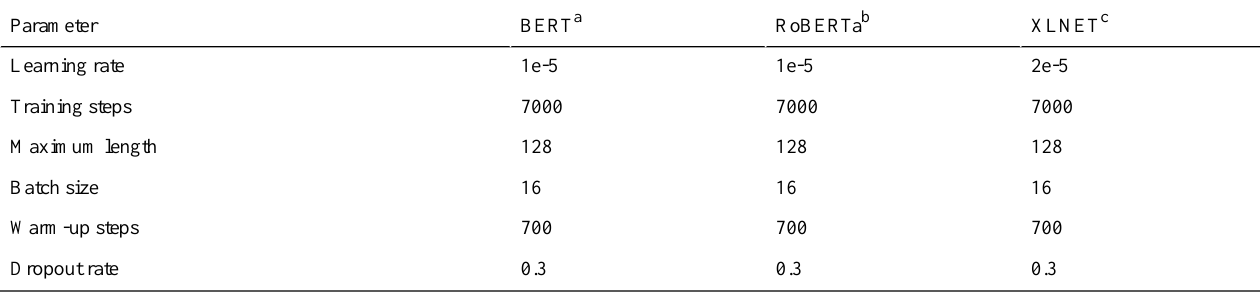
Table 3. Hyperparameters for the deep-learning